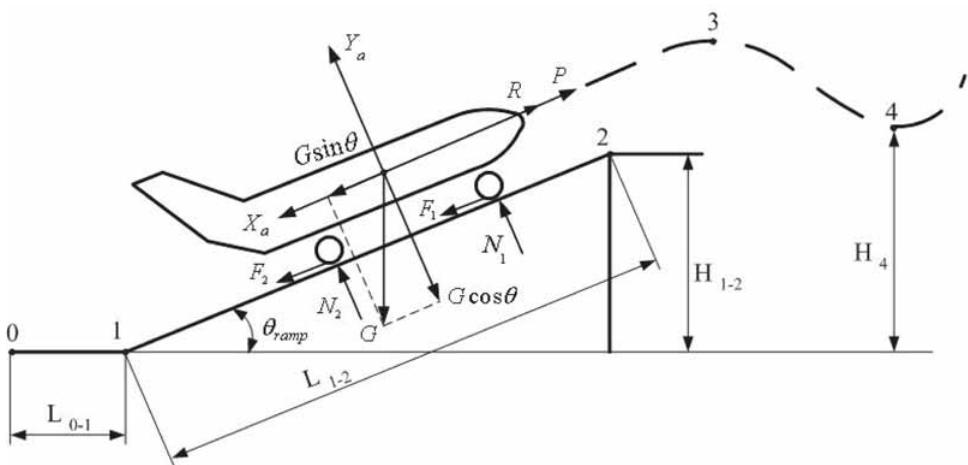
Fig. 1. Model of a